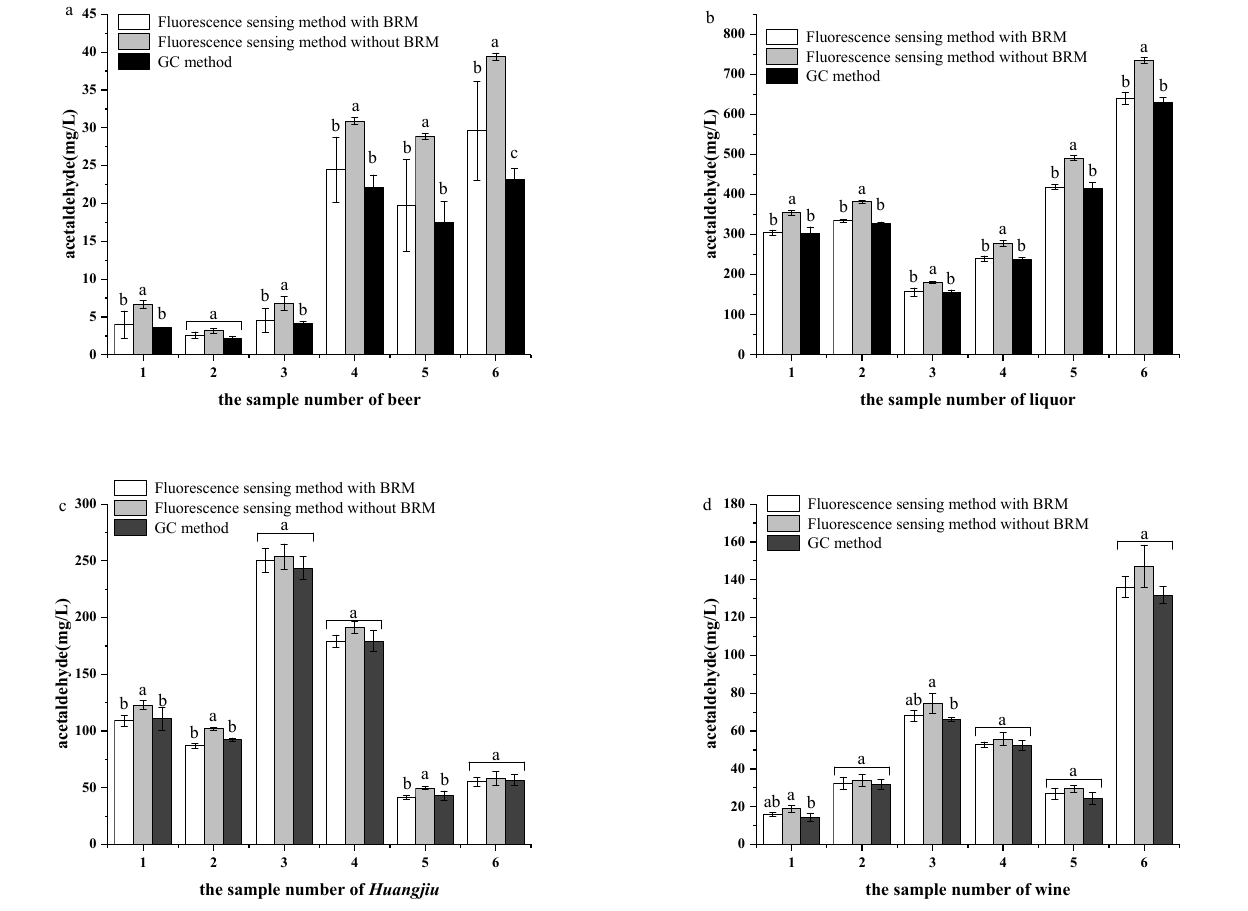
Figure 7. ( a ) Determination of acetaldehyde concentrations in the samples of beer by the fluorescence sensing method and GC method. ( b ) Determination of acetaldehyde concentrations in the samples of liquor by the fluorescence sensing method and GC method. ( c ) Determination of acetaldehyde concentrations in the samples of Huangjiu by the fluorescence sensing method and GC method. ( d ) Determination of acetaldehyde concentrations in the samples of wine by the fluorescence sensing method and GC method. Mean values in each detection method group with superscript letters indicate significant differences. Statistically significant differences were considered for p < 0.05. a,b : Values followed by the same letter do not differ significantly. The basic information of each sample is shown in Tables S1–S4. Tests were performed in triplicate.